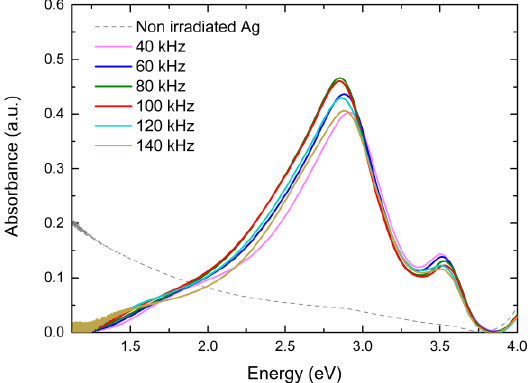
Figure 6. Absorbance spectra for areas of a 6 nm Ag film, Ag #4, irradiated with various laser frequency values.